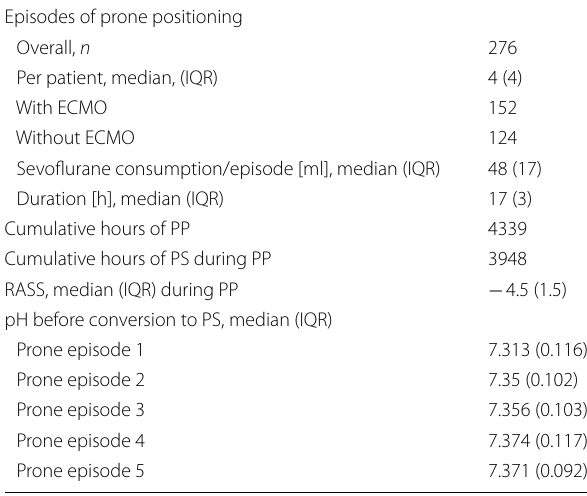
Table 2 Details on episodes of prone positioning